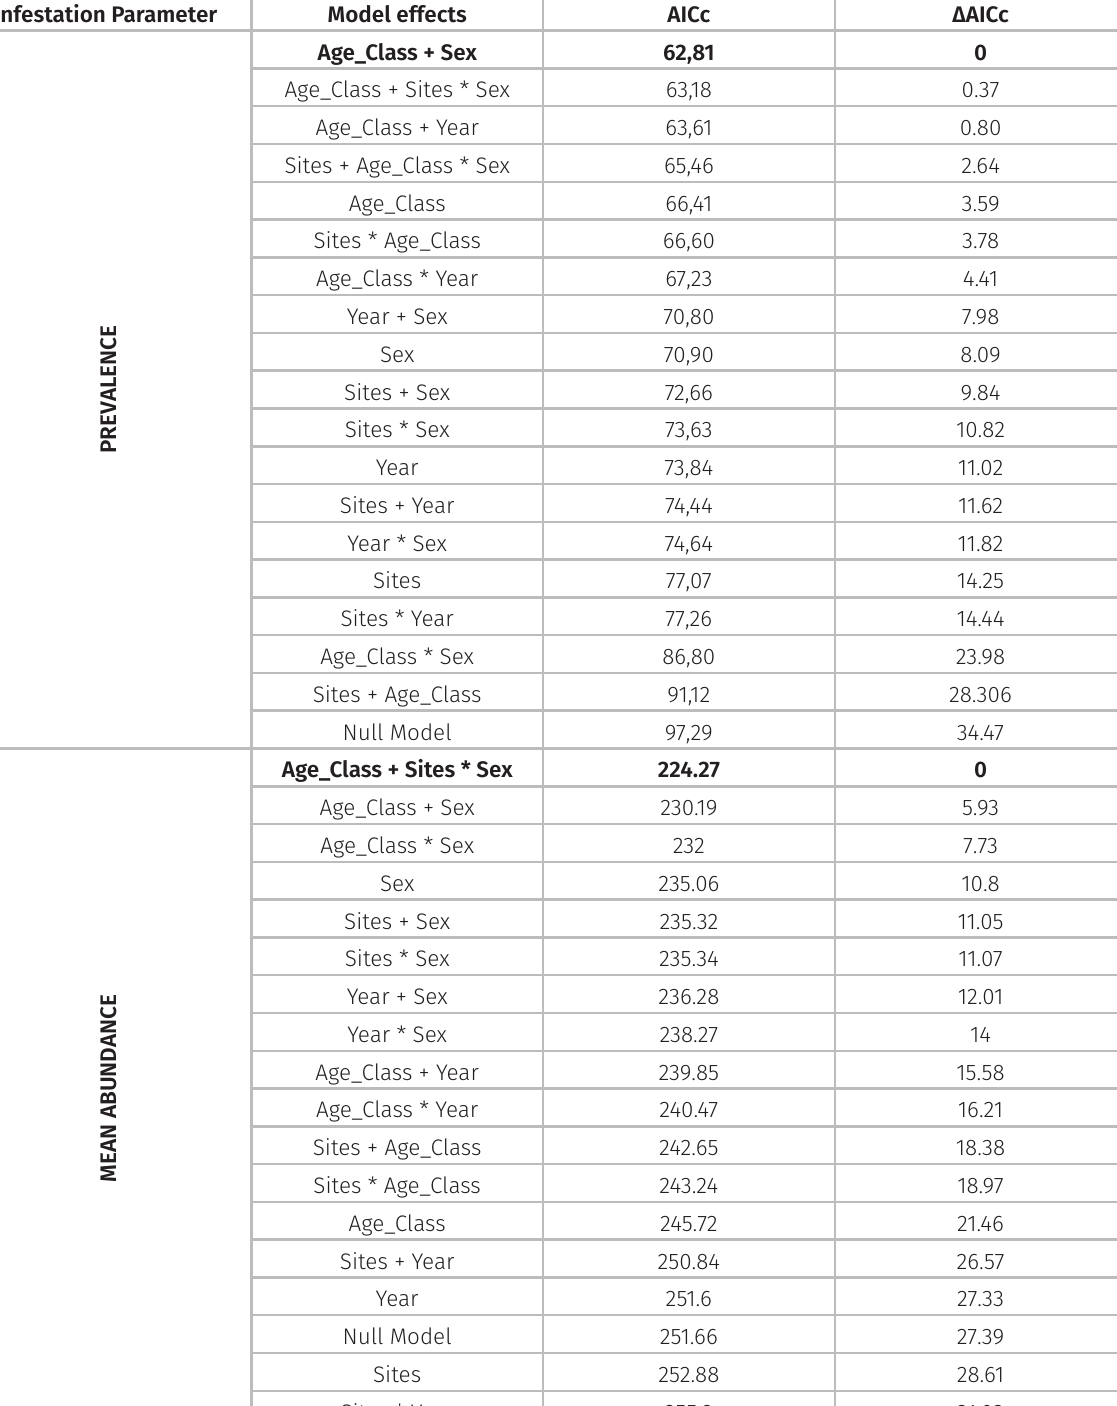
Table II. Model selection results for competing models proposed for effects of host sex, age class, year, and sites on the prevalence and mean abundance of Antarctophthirus carlinii on Weddell seals in the Antarctic Peninsula. In bold the best-supported model. AICc: Akaike Information Criterion corrected for small sample size; ΔAICc, is the difference between the lowest AICc value (i.e. best of suitable models) and AICc from all other